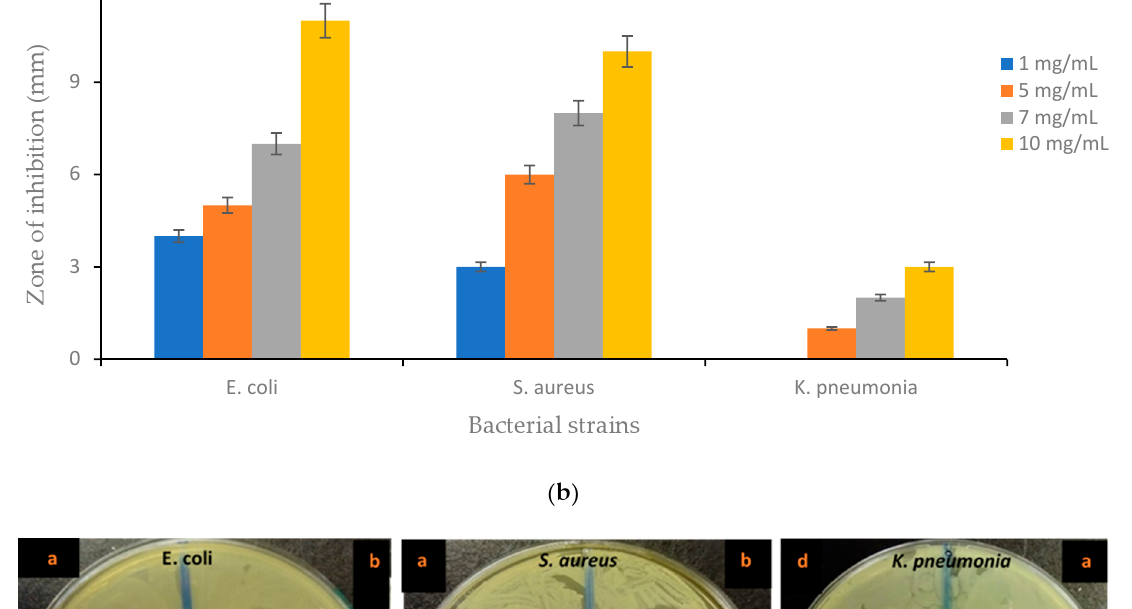
Figure 14. Percent fluoride removal as a function of defluoridation cycle using 0.01 M NaOH and 0.1 M Na 2 CO 3 as regenerates (initial fluoride concentration: 10 mg/L, volume of solution: 50 mL, adsorbent dosage: 0.25 g contact time: 30 min at 250 rpm).